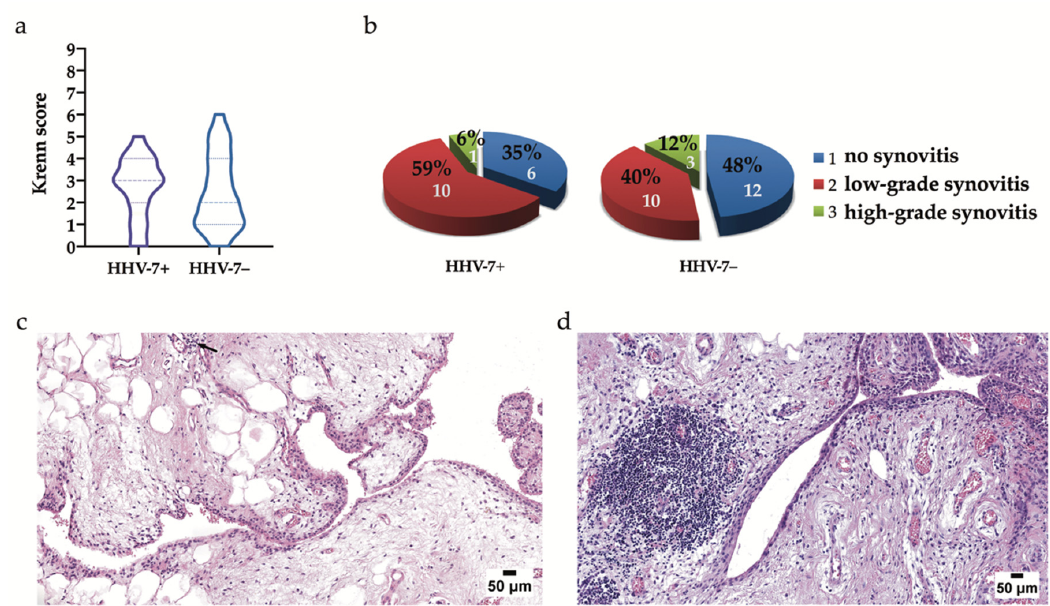
Figure 3. The presence of synovitis assessed by Krenn scores ( a ), statistically ( b ), and morphologically ( c ). ( a ) Violin plots depict the differences in median values demonstrated in the histopathological assessment of Krenn scores from the study groups. Synovitis revealed in the tissue samples of HHV-7 PCR+ OA patients presented with a median value of 3 (IQR 2–4), whereas HHV-7 PCR − OA patients presented with a median value of 2 (IQR 1–4). There was no significant difference found in the synovitis scores estimated for the HHV-7 PCR+ and HHV-7 PCR − groups ( p = 0.483). Simultaneously, Krenn scores tended to be higher in the HHV-7 PCR+ group when compared to the HHV-7 PCR − group. ( b ) Frequencies of the absence of synovitis and the presence of low- and high-grade synovitis detected during histopathological assessment of the synovial membrane tissue samples from the study groups. The estimation confirms that OA patients commonly present without histopathologically detectable synovitis or demonstrate low-grade synovial inflammation. ( c ) A representative image depicting low-grade synovitis in OA. The synovial lining layer is slightly thickened, and the stromal density is slightly increased; few perivascular lymphocytes are evident (arrow). Hematoxylin and eosin staining. ( d ) A low-power image demonstrating high-grade synovitis in OA. The synovial lining layer is moderately thickened, and some lymphocytes are evident; stroma reveals moderate activation, whereas perivascular inflammatory cells and lymphatic follicle characterize the inflammatory component. Hematoxylin and eosin staining. Scale bars: 50 μ m.